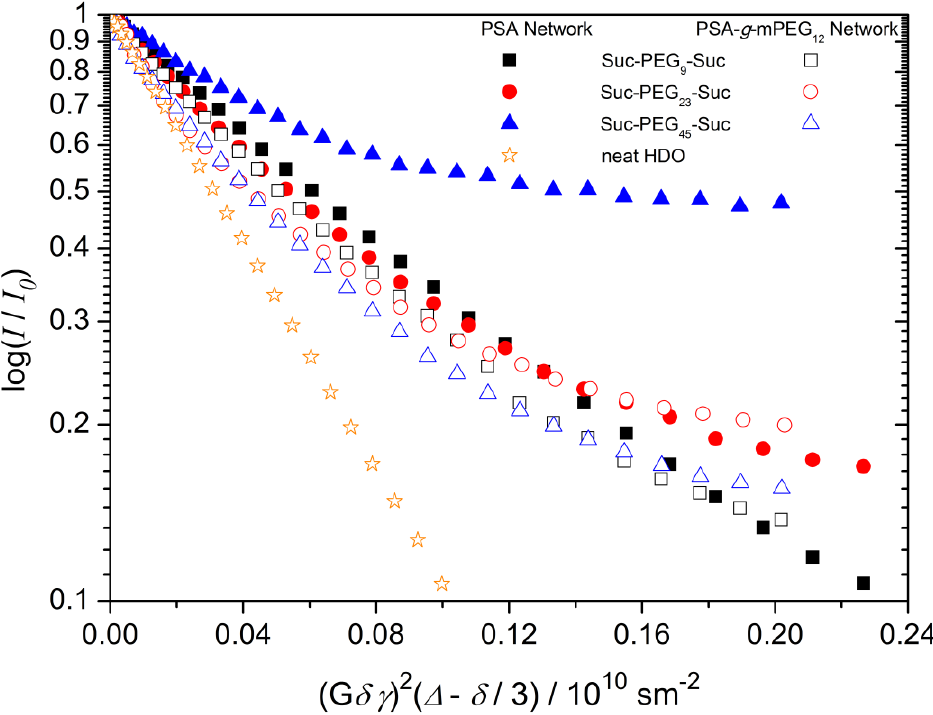
Figure 8. Normalized PFG NMR diffusion decays of HDO for different samples at T = 30 °C. Due to the intensity offset coming from the polymer signal, the initial slope does not reflect the translational diffusion coefficient of water ( D HDO ) in the polymer network correctly.